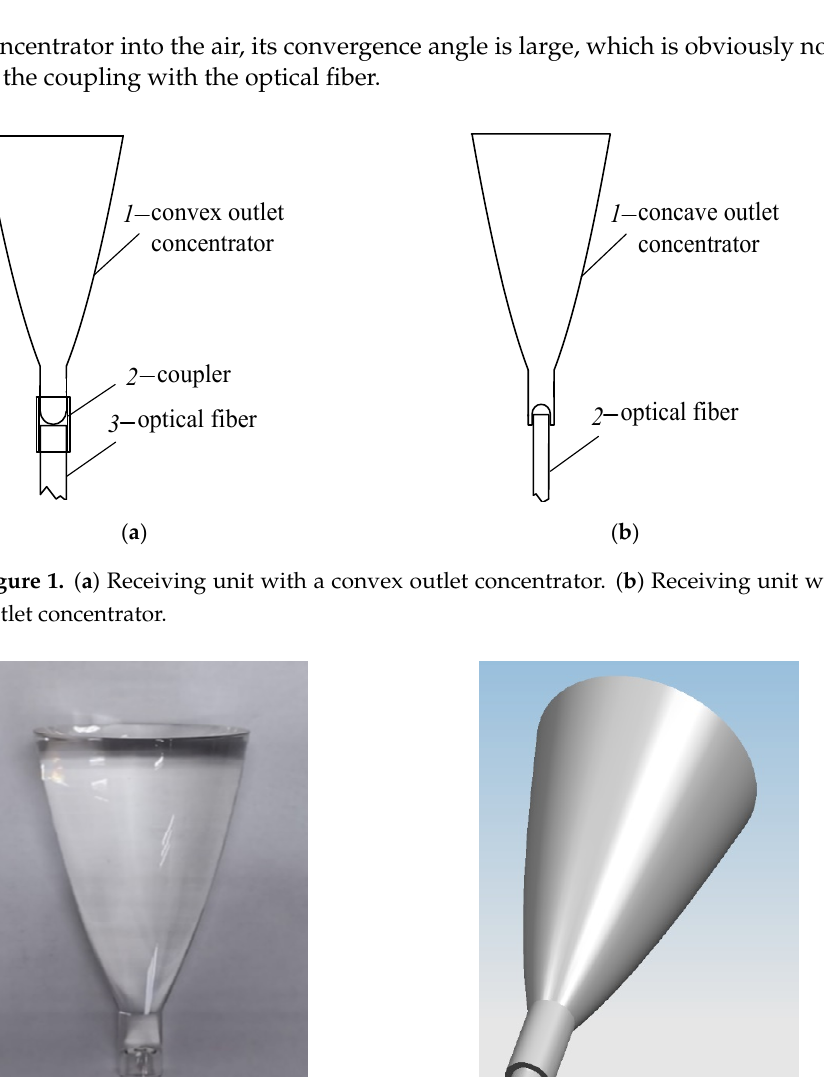
Figure 2. ( a ) Physical photo of the concave outlet concentrator. ( b ) A computer model of the concave outlet concentrator.